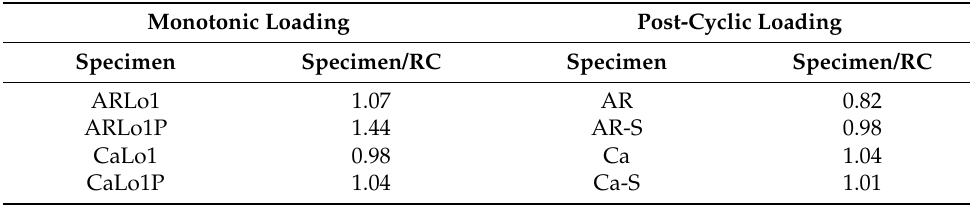
Table 5. Comparison results of flexural stiffness at